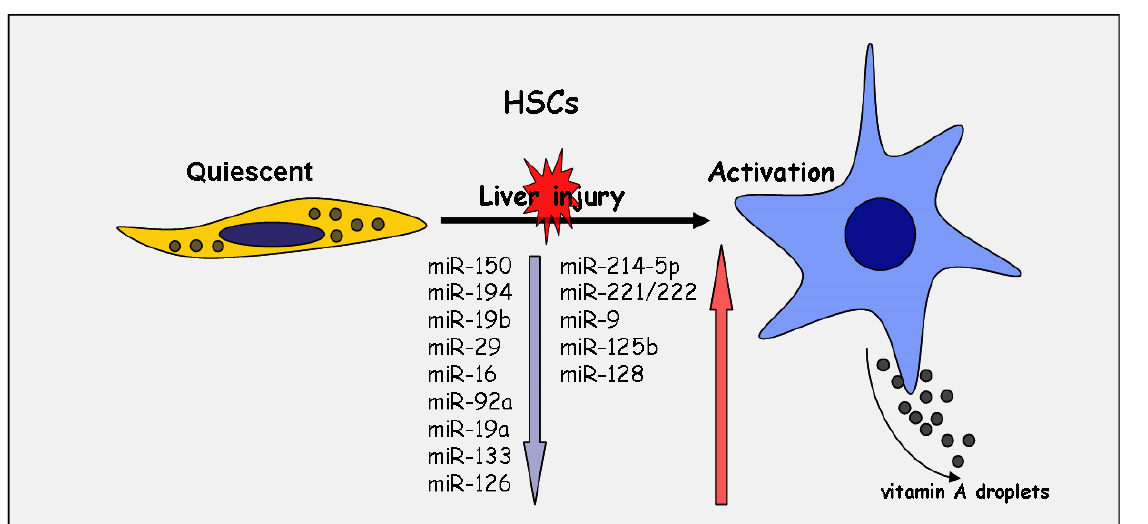
Figure 1. Altered expression pattern of microRNAs during myofibroblastic activation of hepatic stellate cells